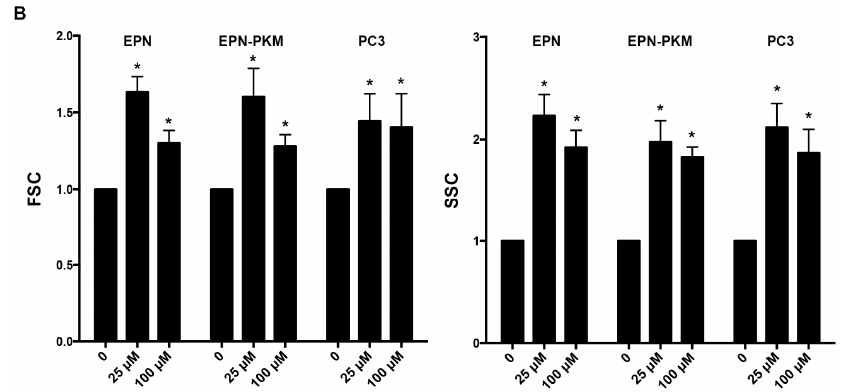
Figure 4. RSV alters shape and size of EPN, EPN-PKM and PC3 cells: ( A ) Microphotographs of representative fields of EPN, EPN-PKM and PC3 cells cultured in standard growing condition or in the presence of 25 and 100 μ M RSV for 72 h. Cells have been observed with Axiovert 25 and photographed with Canon GC5 (final magnification 65×); ( B ) Relative size and internal complexity of EPN, EPN-PKM and PC3 cells in control conditions and treated with 25 and 100 μ M RSV have been evaluated by flow cytometry, in terms of FSC and SSC respectively. (*) indicates statistically significant differences ( p < 0.05) between treated and untreated EPN cells.